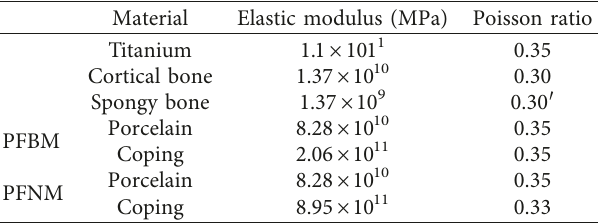
Figure 1: 3D model of implant angulation and three-unit FPD. Table 1: Material properties.